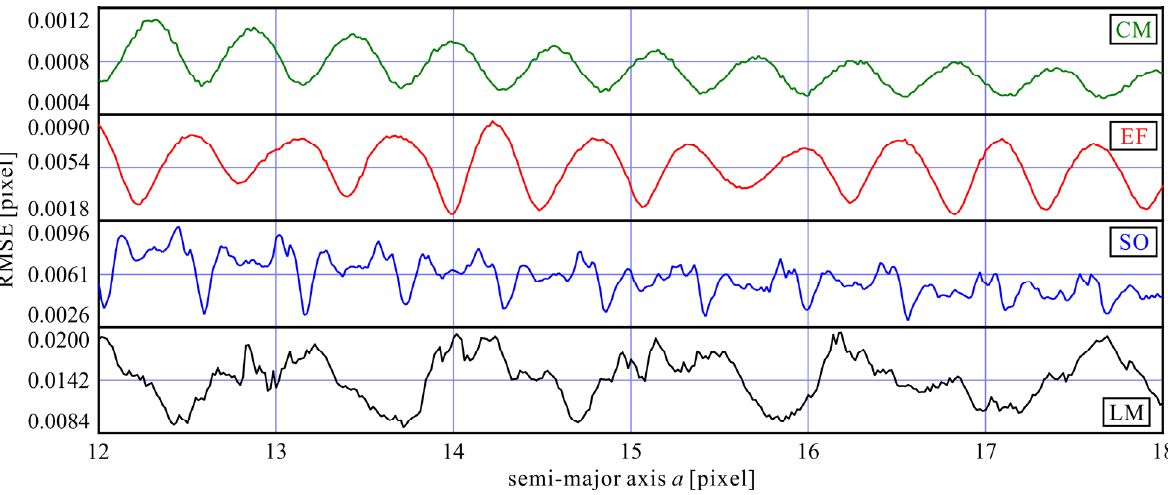
Figure 9. RMSE of the center location measurement of an ellipse (12 pixels  a  18 pixels, f = 0.25,  = 45.0º)